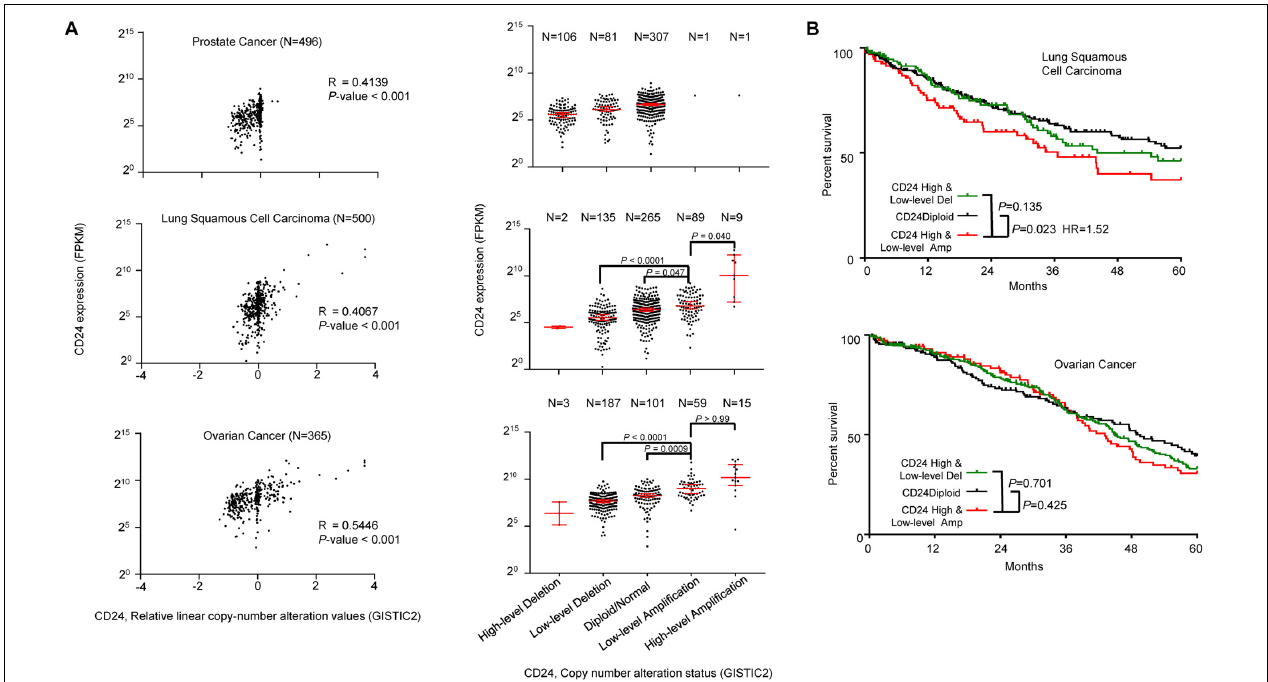
FIGURE 6 | CD24 amplification in different cancer types. (A) Scatter plot (left) and dot plot (right) showing the positive correlation between CD24 copy number values defined by GISTIC2 approach and mRNA expression values quantified by FPKM in prostate cancer (top), lung squamous cell carcinoma (middle) and ovarian cancer (bottom). (B) Kaplan–Meier survival curve comparing the OS time for different CD24 copy number subtypes in lung squamous cell carcinoma (top) and ovarian cancer (bottom). The Spearman coefficient of correlation (R) and significance in panel (A) (left) was determined by linear regression. Statistical significance was determined by the One-way ANOVA in panel (A) (right) and log-rank test in panel (B)